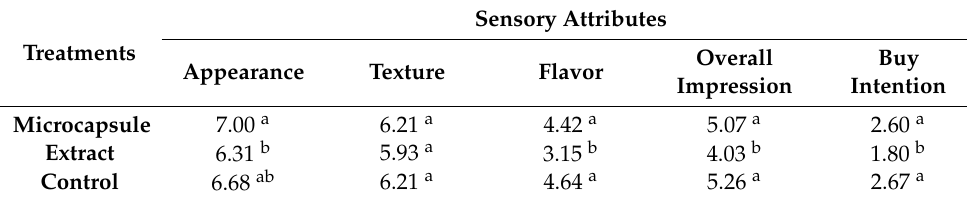
Table 4. Acceptance of different fermented non-dairy beverages with potential probiotic co-cultures plus propolis.